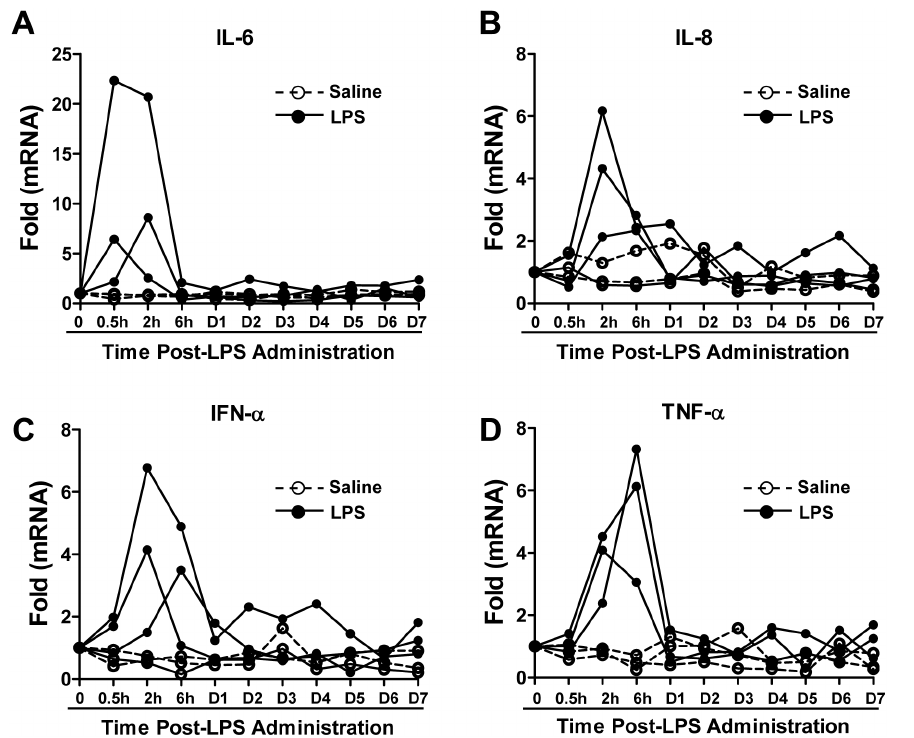
Figure 5. Effect of LPS on inflammatory cytokines in PBMCs. SIVmac239-infected animals were intravenously injected with a single dose of LPS (50 m g/kg, solid circles and lines, n=3) or saline (open circle and dashed lines, n=3) at 45 weeks postinfection. Blood samples were collected at indicated time points post-LPS administration and PBMCs were isolated. The levels of cytokines (IL-6, IL-8, IFN- a , and TNF- a ) in PBMCs were determined by real-time PCR and normalized to GAPDH mRNA. Data are expressed as fold of control (before LPS administration, cytokine mRNA/ GAPDH mRNA, which was defined as 1).